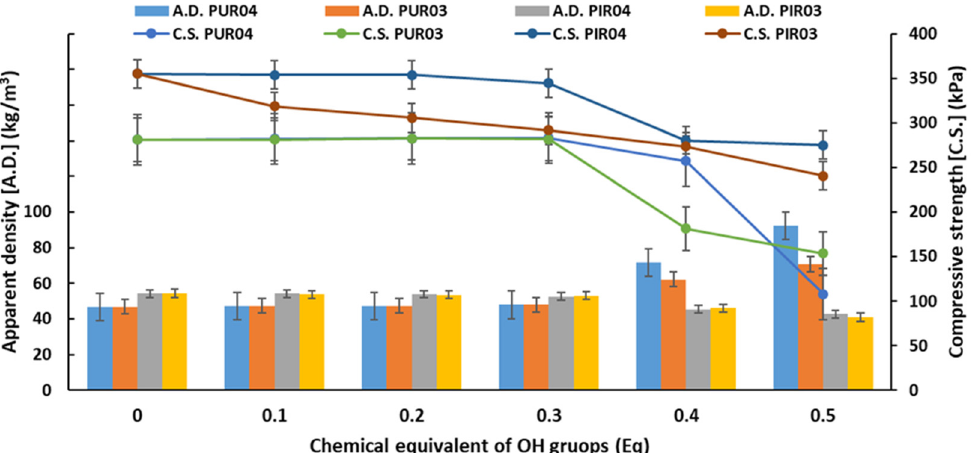
Figure 7. Dependence of apparent density (A.D.) and compressive strength (C.S.) on the content of eco-polyols based on waste PLA.